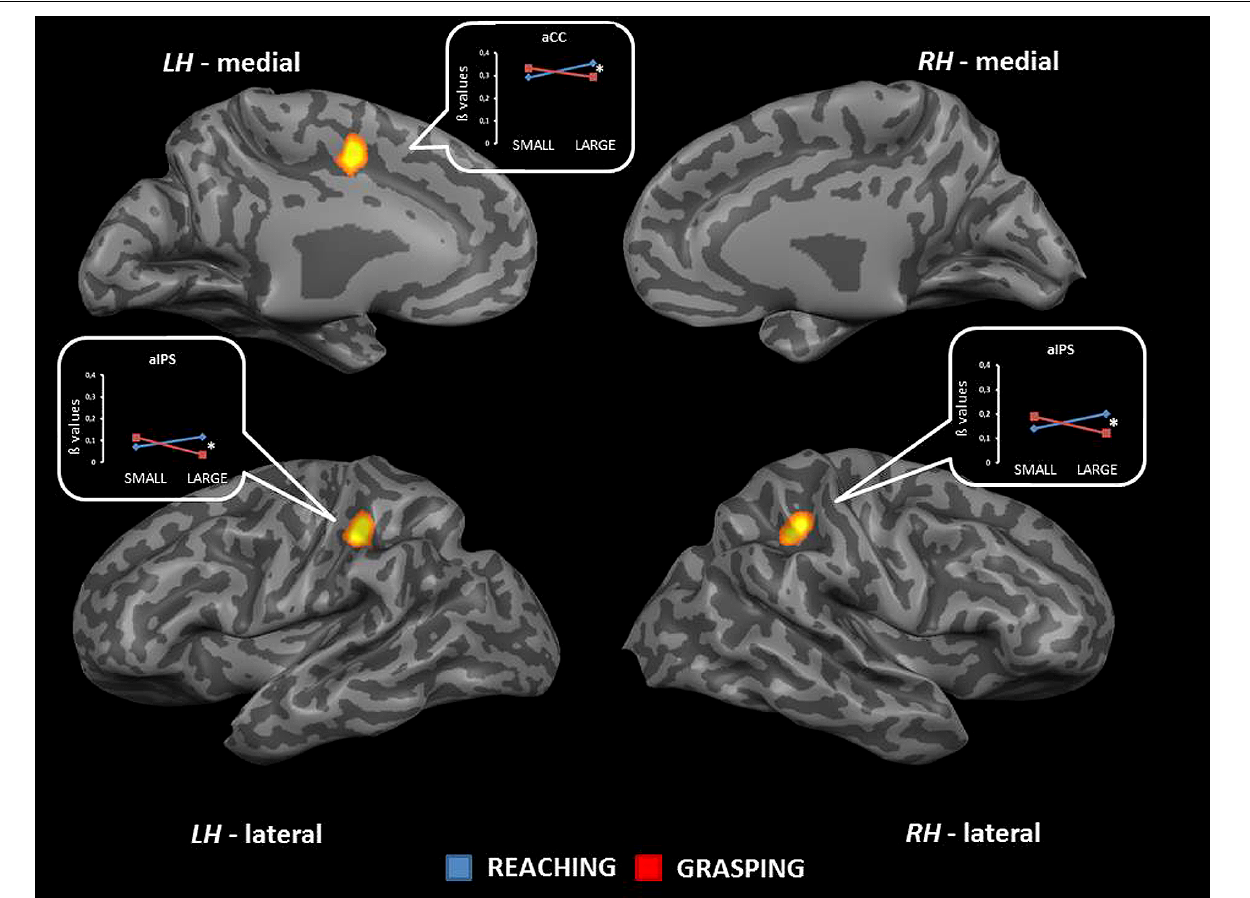
FIGURE 4 | Brain regions showing significant interaction effects between type of movement and stimulus dimension inTB 6. The p value is set to 0.001, uncorrected for multiple comparisons, cluster size k ≥ 13.White